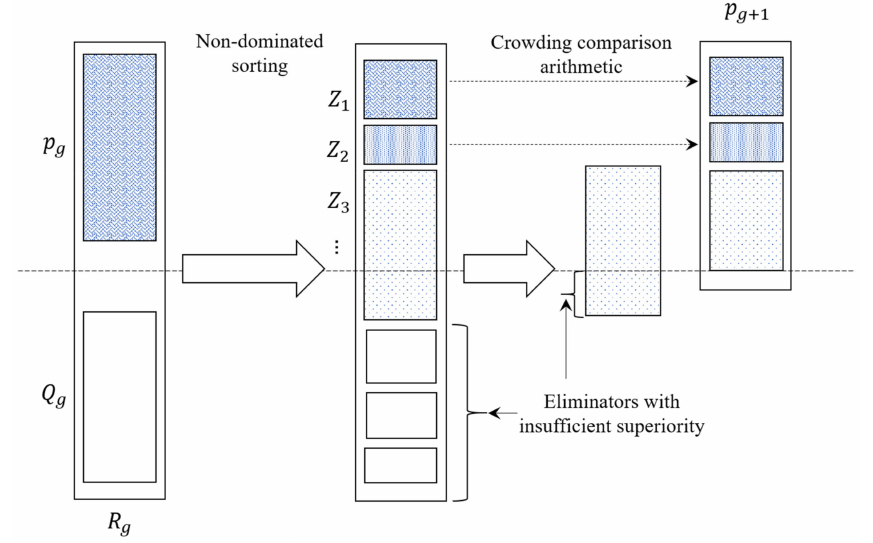
Figure 3. Analysis chart of elite